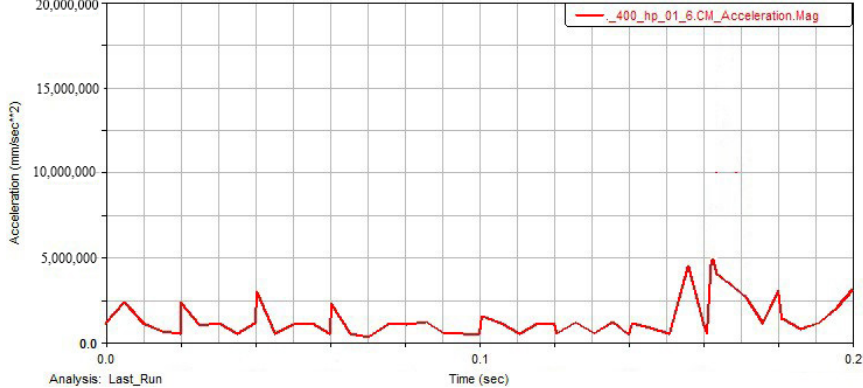
Figure 11. Comparison of slider acceleration before stator optimization.